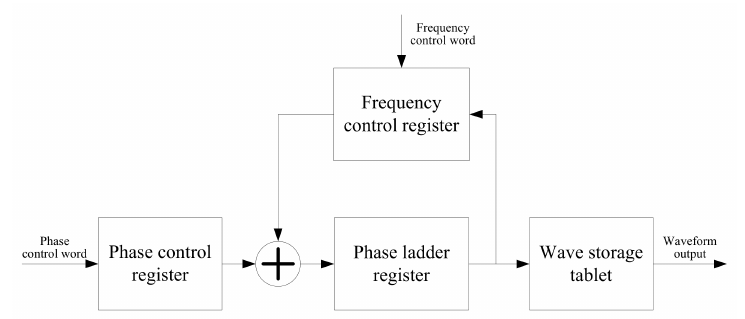
Figure 5. Schematic diagram of DDS.